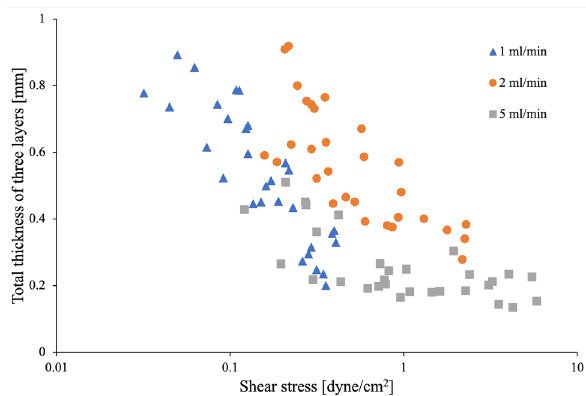
Figure 11. Relationship between the total thickness of the three layers in matured tissue (i.e., infiltration depth into the scaffold) and the shear stress.